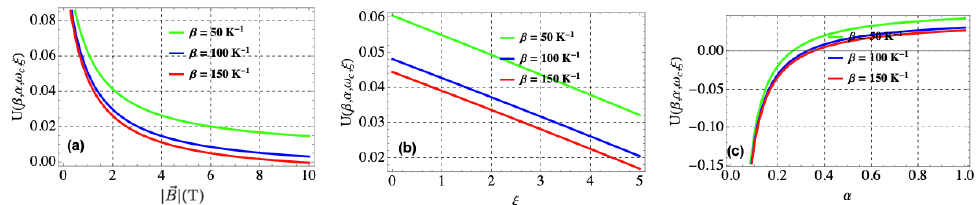
Figure 4. Plot of mean energy U ( β ) as a function of magnetic field | (cid:126) B | ( T ) ( a ), AB field ξ ( b ) and topological defect α ( c ) for different values of β = 50 k − 1 (green curve), 100 k − 1 (blue curve) and 150 k − 1 (red curve); all other parameters are the same as in Figure